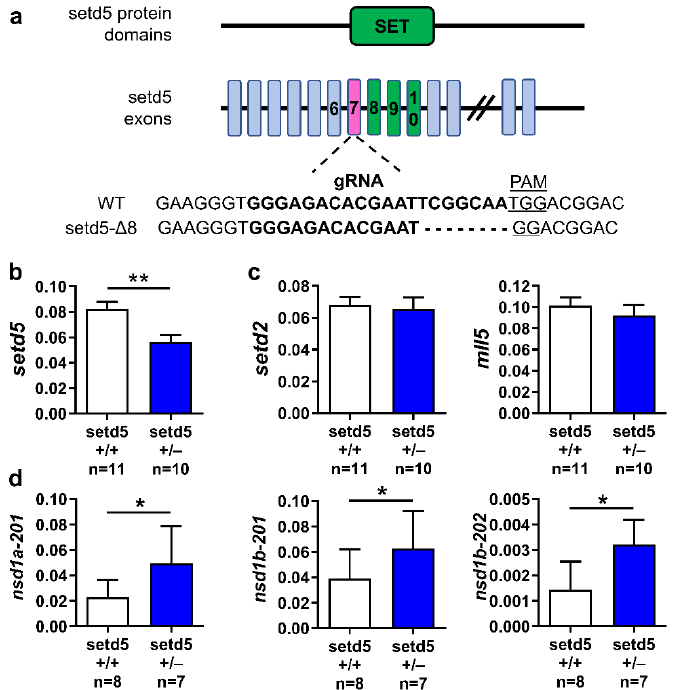
Figure 2. Location of the eight-nucleotide deletion in setd5 gene (setd5- ∆ 8) and its effects on the expression of selected genes. ( a ) Schematic representation of the main zebrafish Setd5 protein domains and the corresponding exons, highlighting the SET domain (in green). The 20-nucleotide sequence corresponding to gRNA in exon 7 (in magenta) encoding sequence is indicated, as well as the PAM sequence, aligned to the deleted setd5 mutant sequence obtained by CRISPR/Cas9 gene editing technique. ( b – d ) Expression of setd5 ( b ), setd5 paralogues setd2 and mll5 ( c ), nsd1a and nsd1b isoforms ( d ) in setd5 +/+ and setd5 +/ − adult zebrafish brains, obtained by RT-qPCR analysis. The values are expressed as 2 − ( ∆ Ct) , using bactin1 as the housekeeping gene. ( b – d ) n = number of adult brains analyzed. Data are expressed as mean ± SEM. Statistical analysis was performed by Student’s t -test. * p < 0.05; ** p <